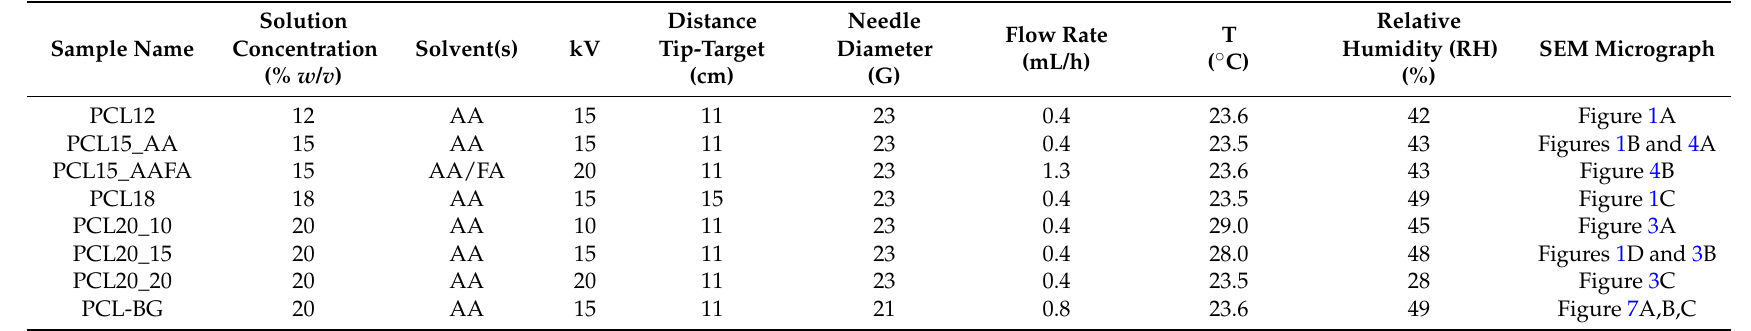
Table 3. Summary of the electrospinning parameters for the different tested solutions and indication of the related SEM micrograph showing the fiber mat